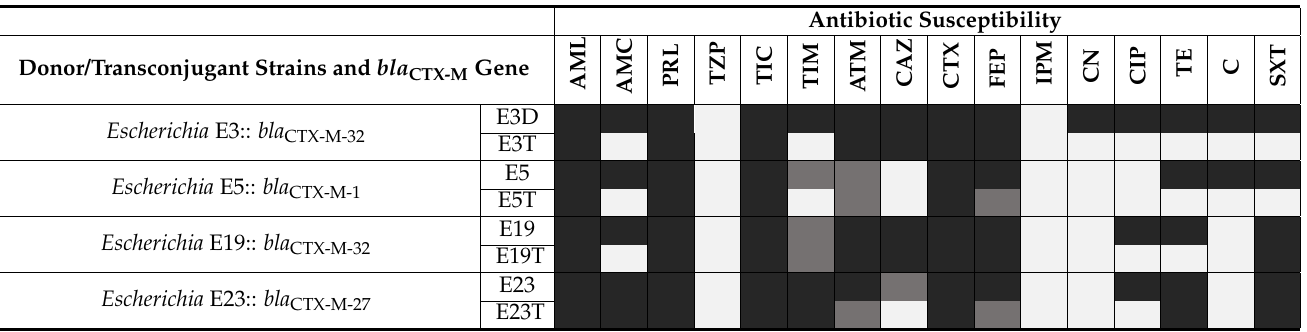
Table 2. Antibiotic susceptibility profiles of donor and transconjugant strains carrying bla CTX-M genes and recipient strain E. coli CV601 (black—resistant, grey—intermediate resistance,